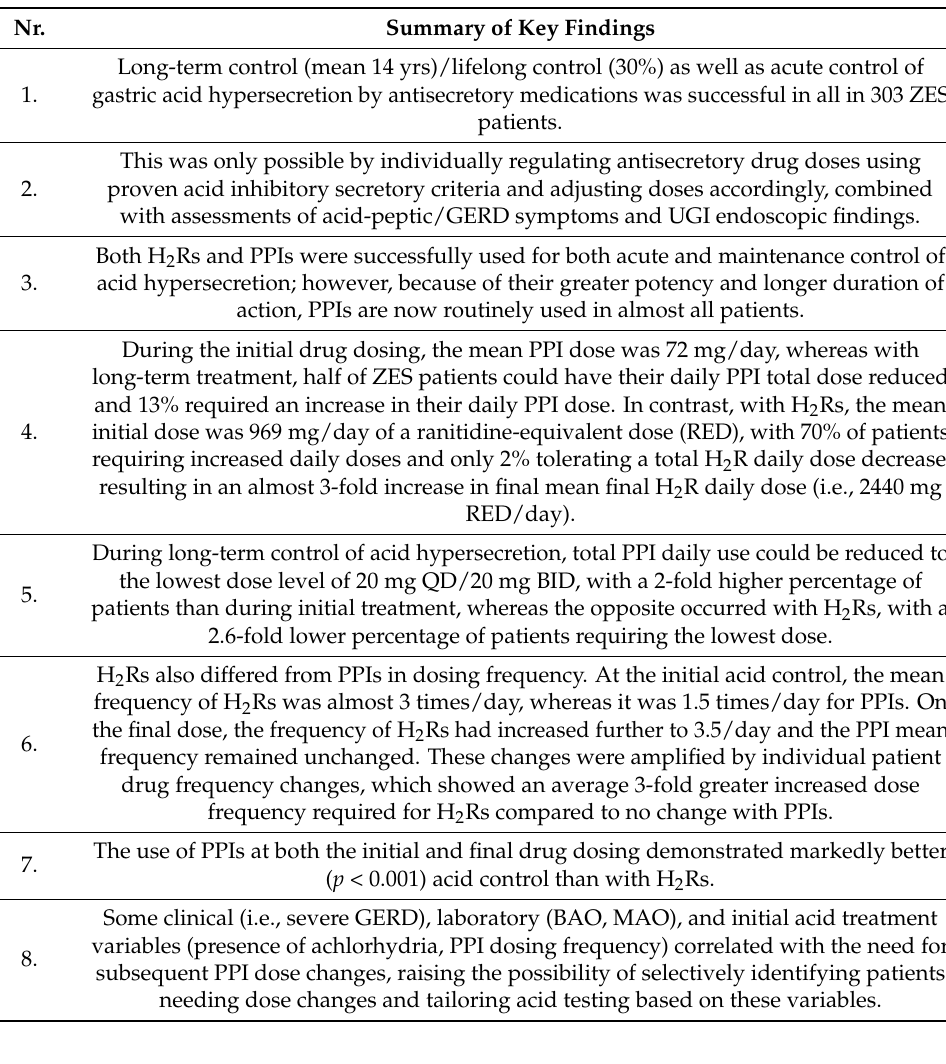
Table 8. Summary of key